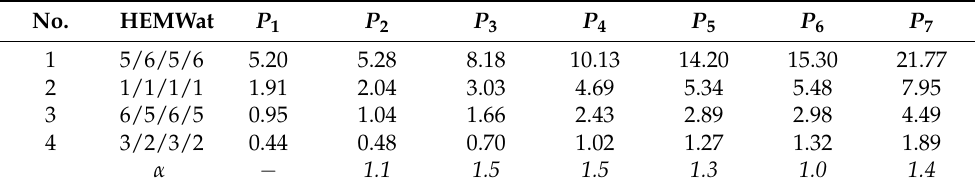
Figure 1. HPLC-DAD chromatogram of Ferula penninervis methanolic root extract. olgin ( 1 ), ferupennin P ( 2 ), laferin ( 3 ), olgoferin ( 4 ), oferin ( 5 ), ferupennin Q ( 6 ) and daucoguainolactone F ( 7 ). Table 1. Partition coefficient values of the target compounds from Ferula penninervis methanolic root